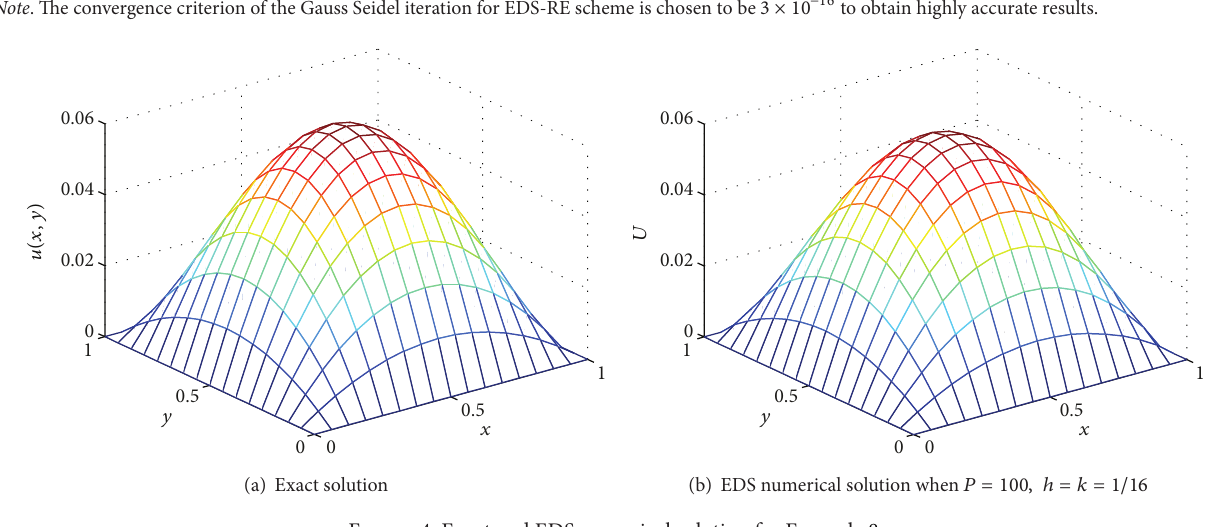
Figure 4: Exact and EDS numerical solution for Example 8.